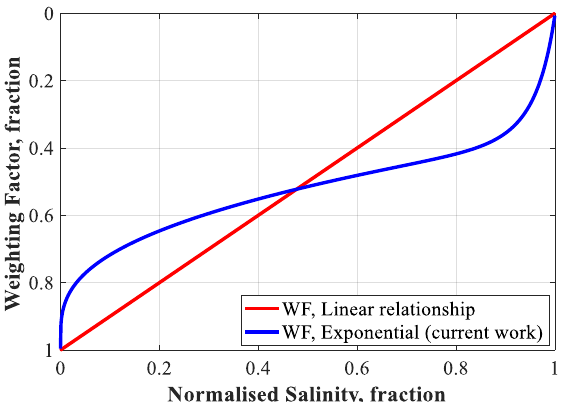
Figure 4. A comparison between the weighting factors of the mixing zone using the linear relationship in Equation (3) and the derived exponential relationship, as illustrated in Equation (4). The weighting factor value of one represents the beginning if the low salinity in the mixing zone. Meanwhile, a zero-weighting factor value represents the end of the mixing zone with high salinity concentration.